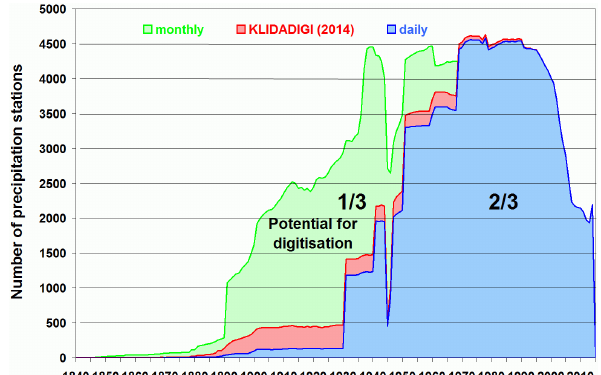
Figure 2. Temporal evolution of the digitally available precipita- tion series and of the digitized records until the end of 2014 (the potential for digitization is the portion of the digitized monthly data that is not yet available as digital daily data).